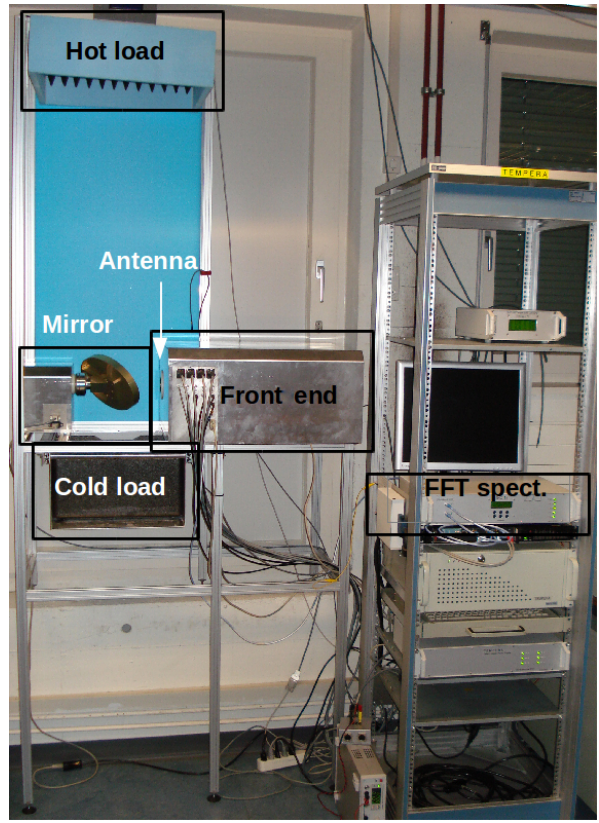
Figure 1. TEMPERA at the laboratory at ExWi, Bern (Switzer- land).